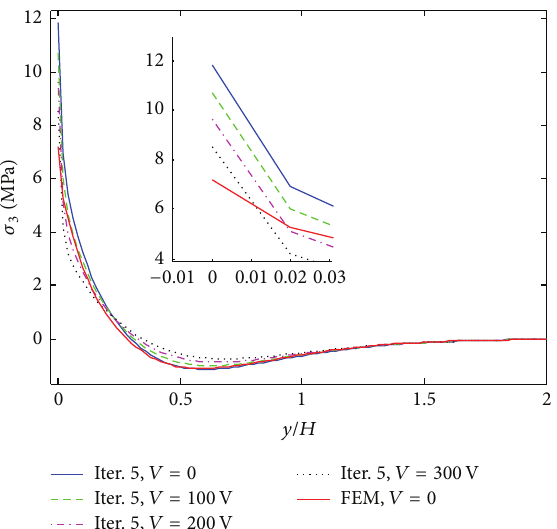
Figure 10: 𝜎 3 distribution of [PZT/45 4 / − 45 4 ]s laminate at the interface of 𝑧/𝐻 = 1/6 , under − 0.1% uniaxial strain.